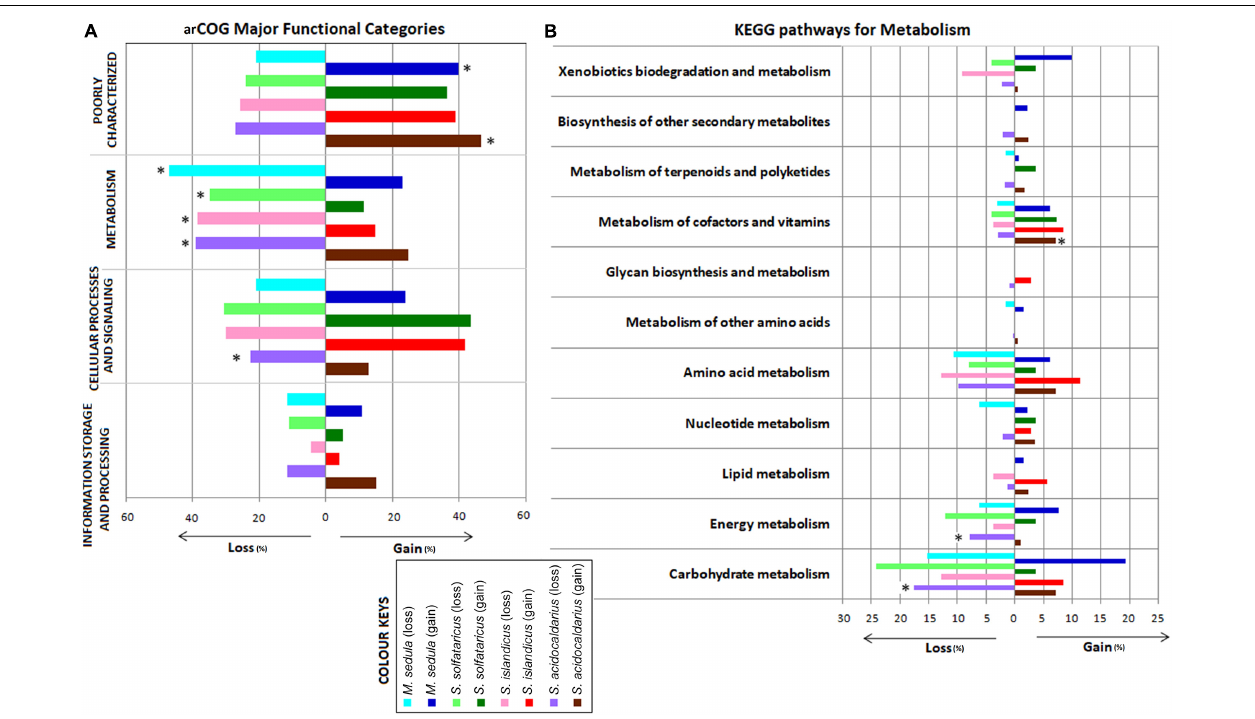
FIGURE 2 | Bar chart showing distribution of major functional categories of Archaeal Clusters of Orthologous Genes (arCOGs) at the species-level gene gain–loss (A) and distribution of the KEGG pathways for metabolism at the species-level gene gain–loss (B) of the family Sulfolobaceae . *Significant difference ( P < 0.05) in that particular gain–loss